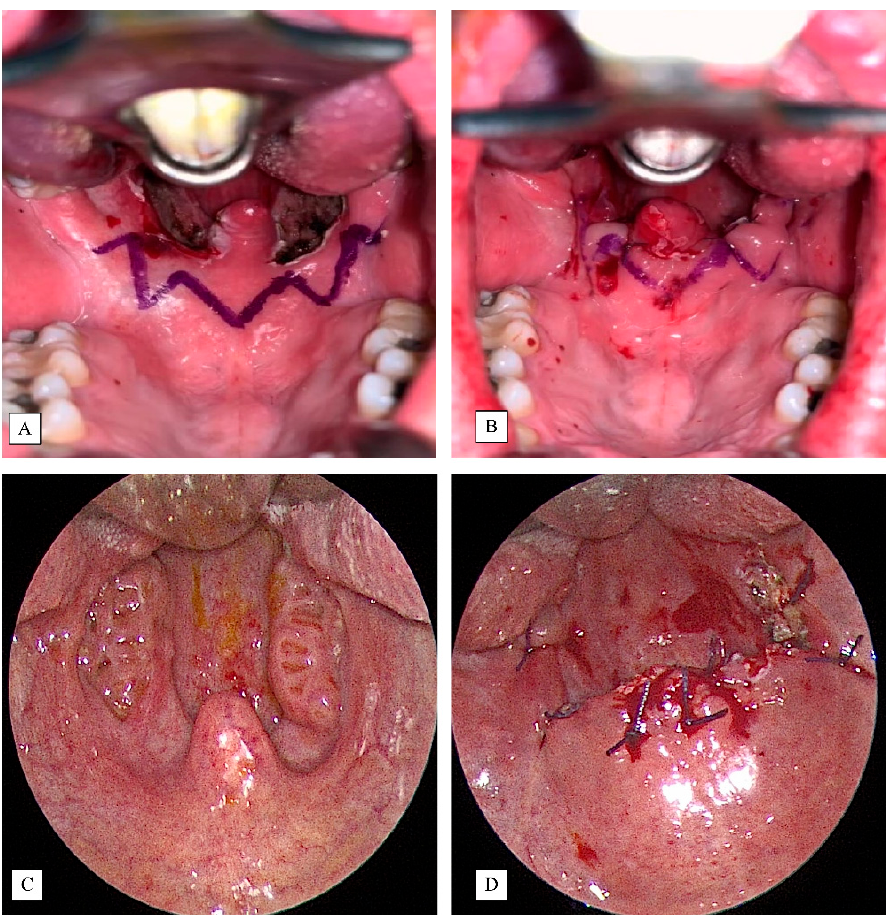
Figure 2. Before ( A ) and after ( B ) barbed suspension pharyngoplasty in the BRP plus TORSTBR group; before ( C ) and after ( D ) modified UPPP in the UPPP plus TORSTBR